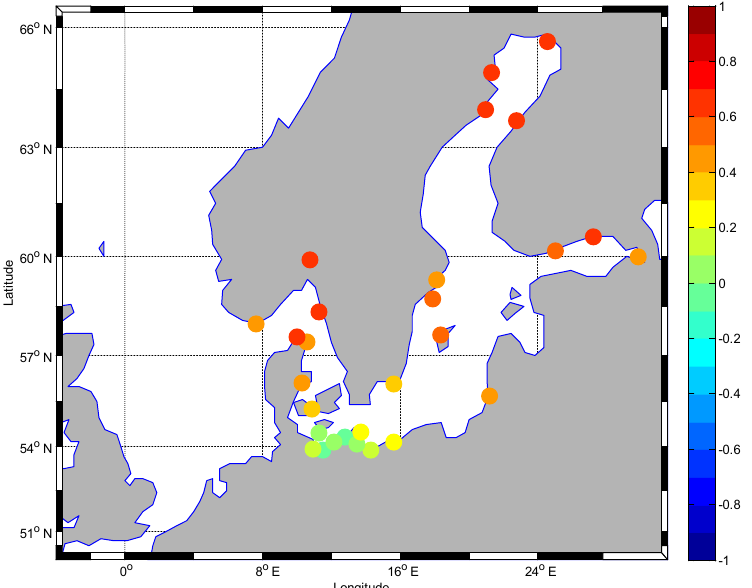
Figure 3. Correlations of decadal gliding trends between the NAO index and 29 tide gauges for wintertime (1900–2012). The 95% signifi- cance level is ± 0.19 for this record